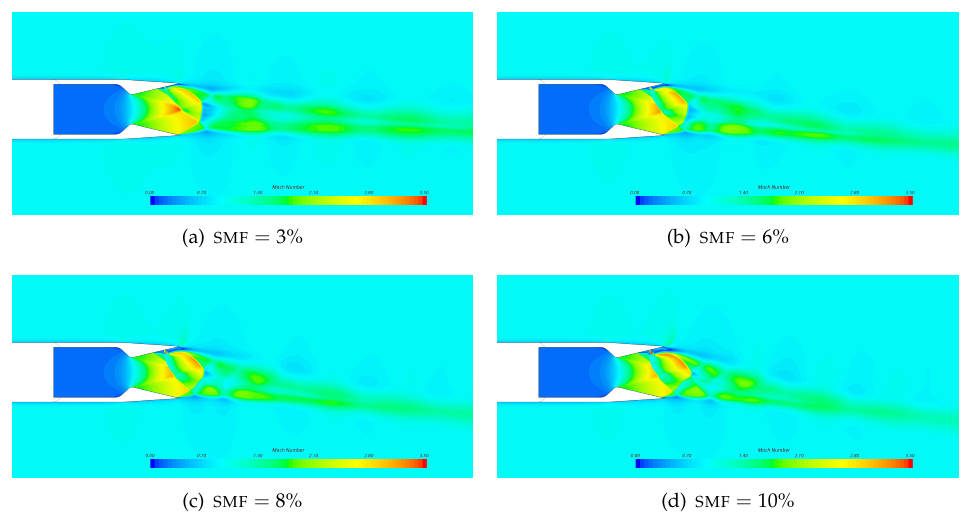
Figure 16. Flowfield in the nozzle symmetry-plane. Mach contour at different secondary mass-flow injection rates ( SMF